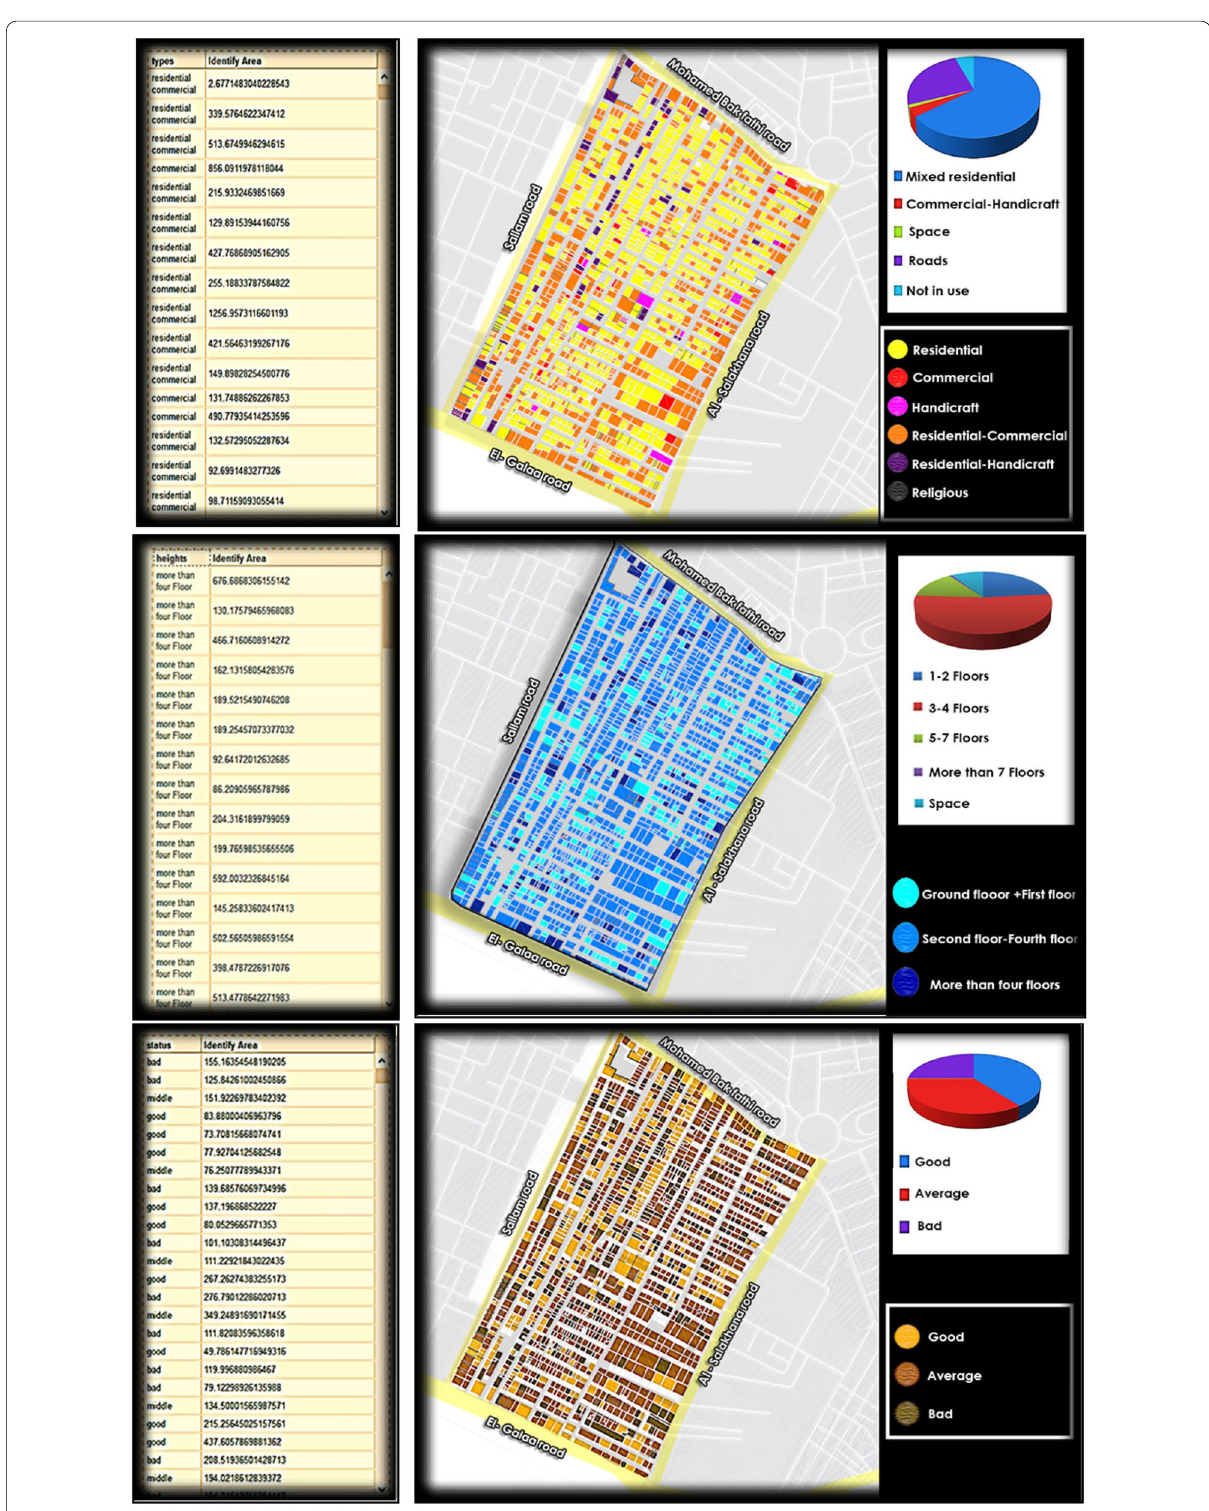
Fig. 4 shows the uses—heights—condition (good—medium—bad) of the buildings in Ezbet El‑Shahatin. Source: The researcher using Arc Map